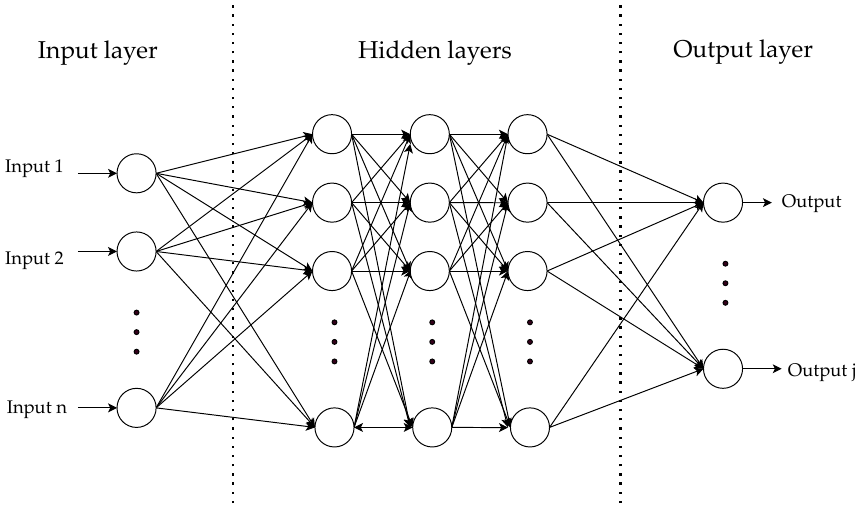
Figure A1. Architecture of an